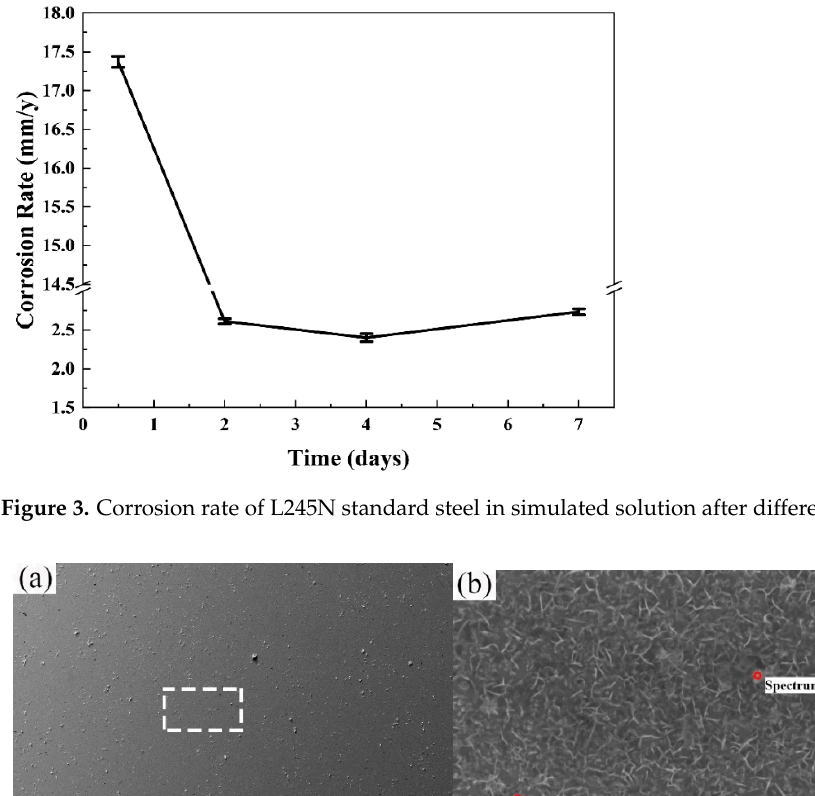
Figure 2. ( a ) OM image and ( b ) SEM image of the metallographic structure of L245N standard steel.